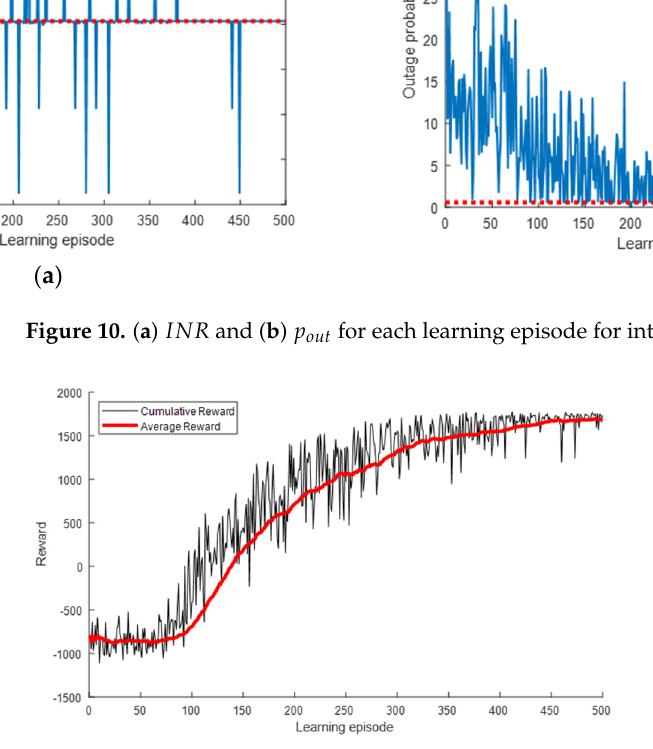
Figure 11. Reward for each learning episode for interfered receiver ① .